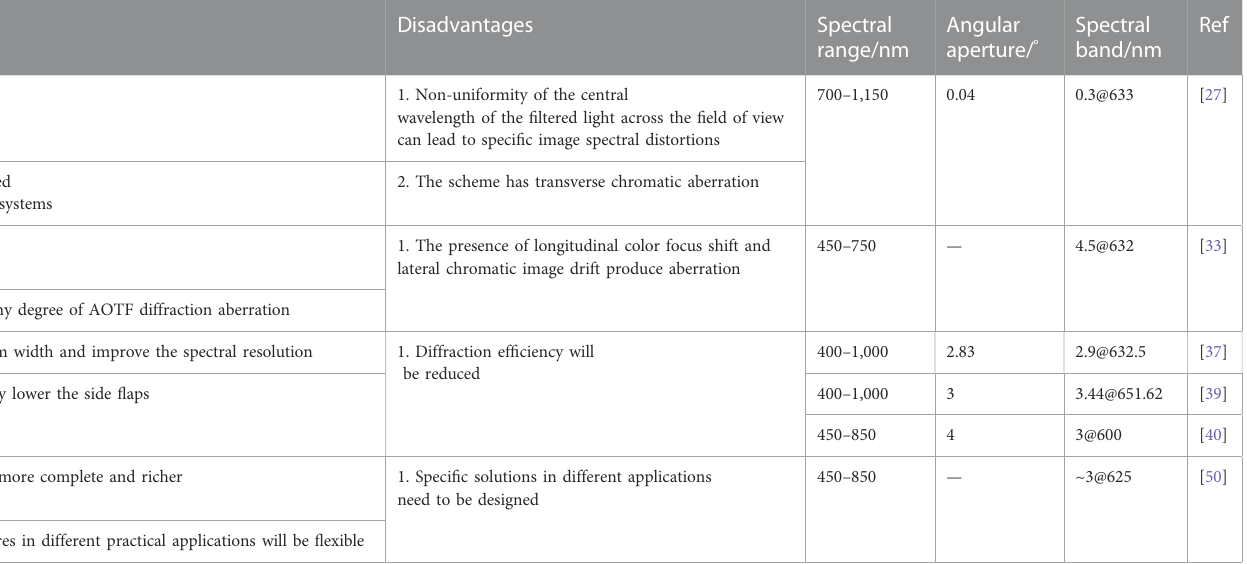
TABLE 1 Comparison of acousto-optic spectral analysis system